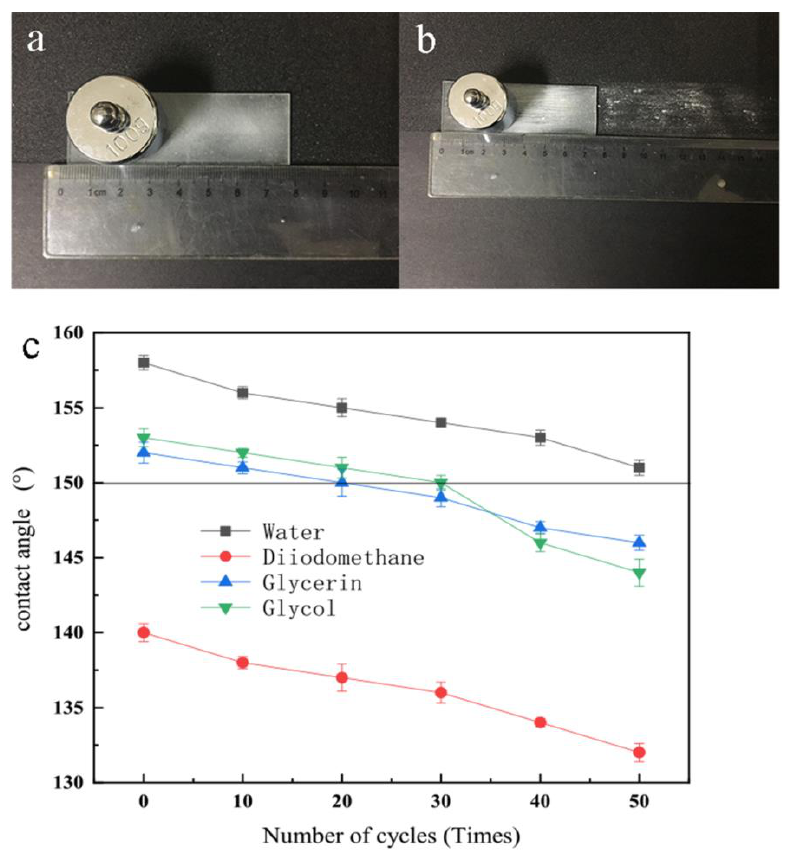
Figure 6. Image of the FEP-S coating ( a ) before and ( b ) after sandpaper abrasion at 10 m, ( c ) CA of four liquids changes of the FEP-S with sandpaper abrasion cycles. As the thickness had a certain influence on the mechanical stability of the coating, especially on the abrasion resistance, the thickness of the FEP-S coating before and after sandpaper abrasion at 10 m was measured by SEM.